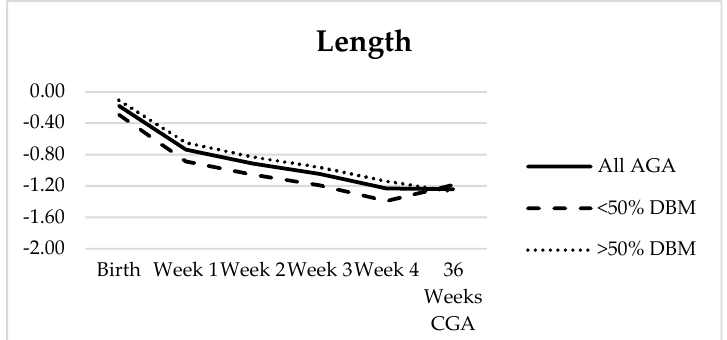
Figure 4. Fenton z-score trajectory for length in all appropriate-for-gestational-age (AGA) infants (solid line, n = 49) and subgroups of < 50% DBM intake (dashed line, n = 18) and > 50% DBM intake (dotted line, n = 31). Average rate of change from week 4 to 36 weeks CGA in the two subgroups were 0.12 and –0.14, respectively ( p = 0.023).